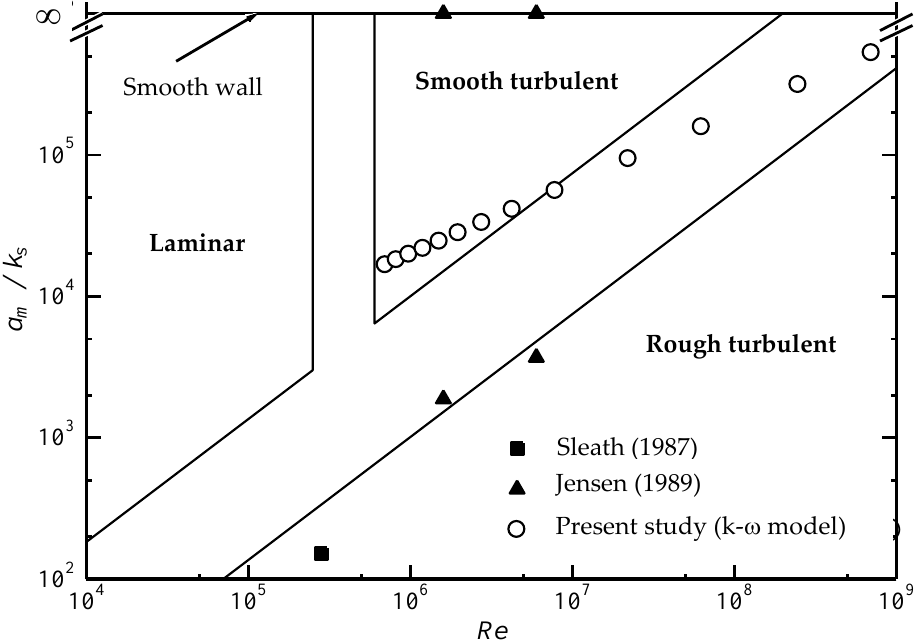
Figure 4. Conditions of experimental studies and k- ω numerical simulation. Table 1. Conditions of laboratory experiments by Sleath [8] and Jensen [30] and k- 𝜔 model